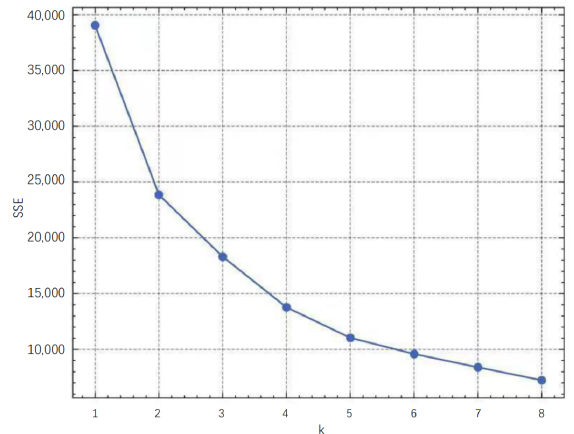
Figure 4. Line chart of the SSE for each value of k